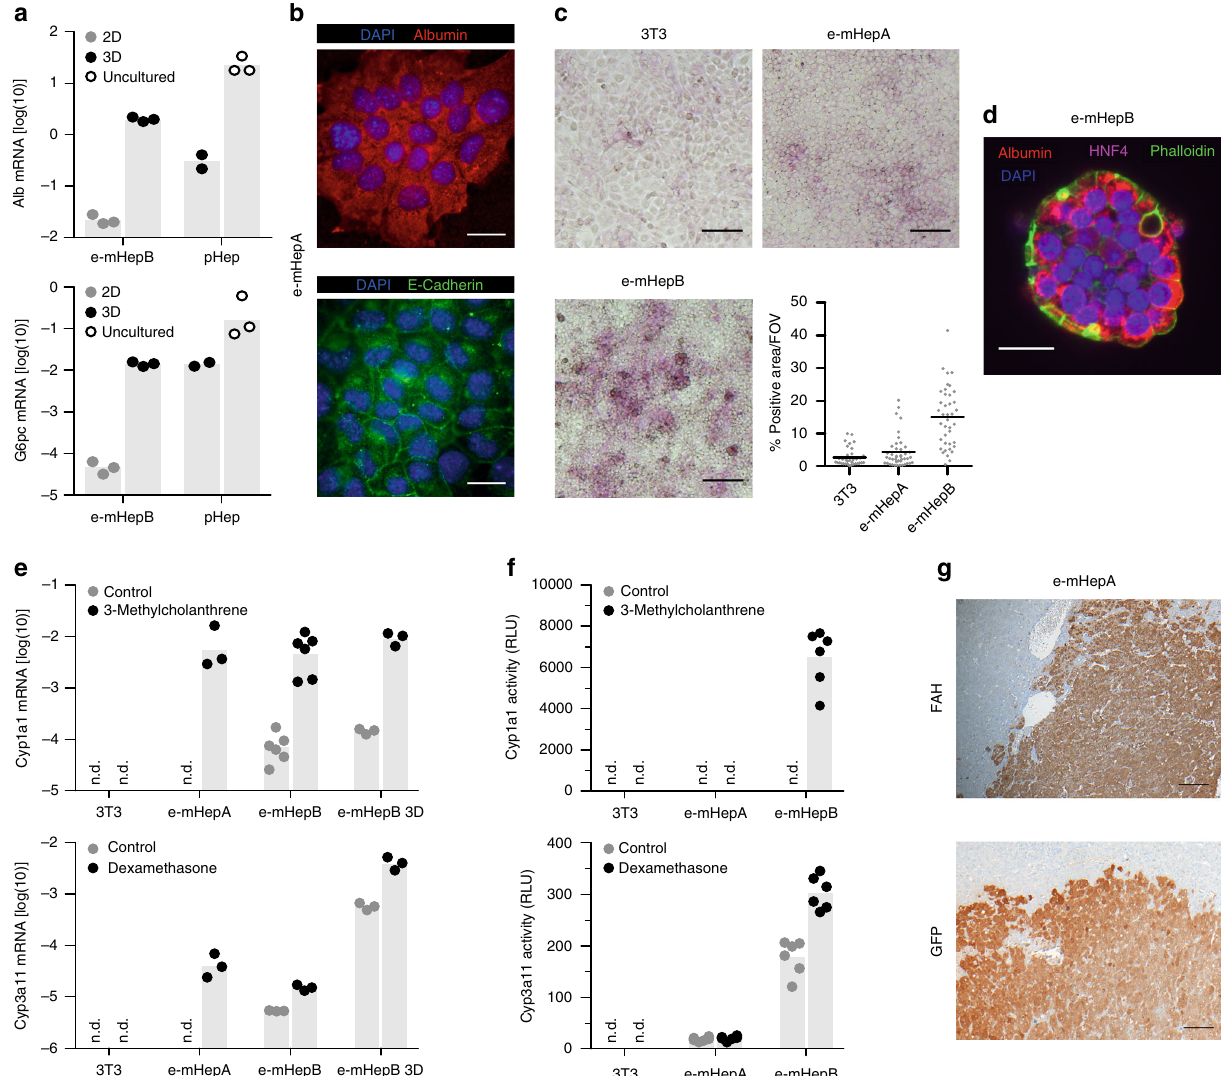
Fig. 2 Hepatocyte cell lines retain key hepatic properties. a Albumin and Glucose-6-phosphatase gene expression analysis of expandable hepatocytes cultured in standard 2D or 3D (9 days of cultivation as spheroids in spinner fl asks) conditions and primary hepatocytes (pHep) either cultured in 3D conditions or freshly isolated (expression normalized to Gapdh, n = 3 independent experiments, except for pHep were n = 2 independent experiments, bars represent mean). b Immuno fl uorescence-based detection of Albumin and E-cadherin in e-mHepA expandable hepatocytes counterstained for nuclei with DAPI. Scale bar, 20 μ m. c Glycogen storage in expandable hepatocytes and control fi broblasts as analyzed by Periodic Acid-Schiff staining. Representative bright fi eld micrographs and quanti fi cation of multiple fi eld of views are shown. Scale bar, 100 μ m (mean, pooled data from n = 3 independent experiments,